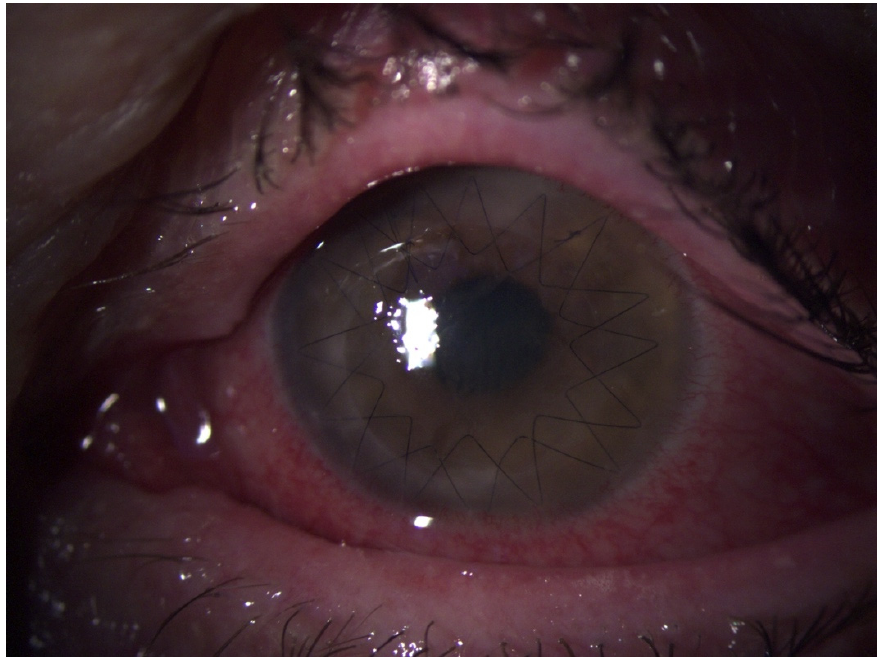
Figure 3. Biomicroscopic slit-lamp photography of the left eye one week after first keratoplasty with again incipient infiltration spreading from the remaining host cornea.